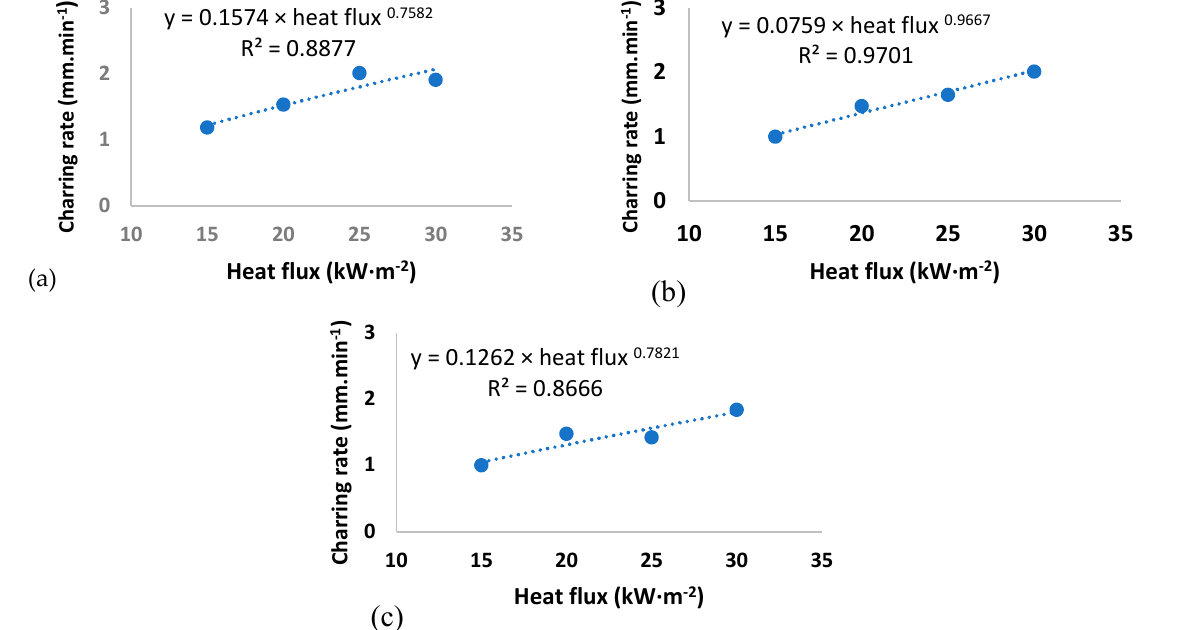
Figure 2. Average charring rate in time interval: ( a ) from 0 to 600 s; ( b ) from 0 to 900 s; ( c ) from 0 to 1920 s.